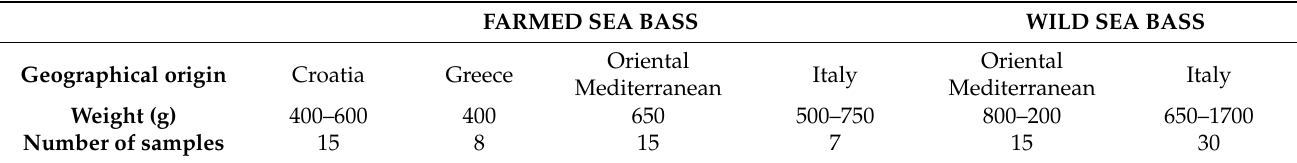
Table 1. Geographical origin, weight, and sample number of farmed and wild sea